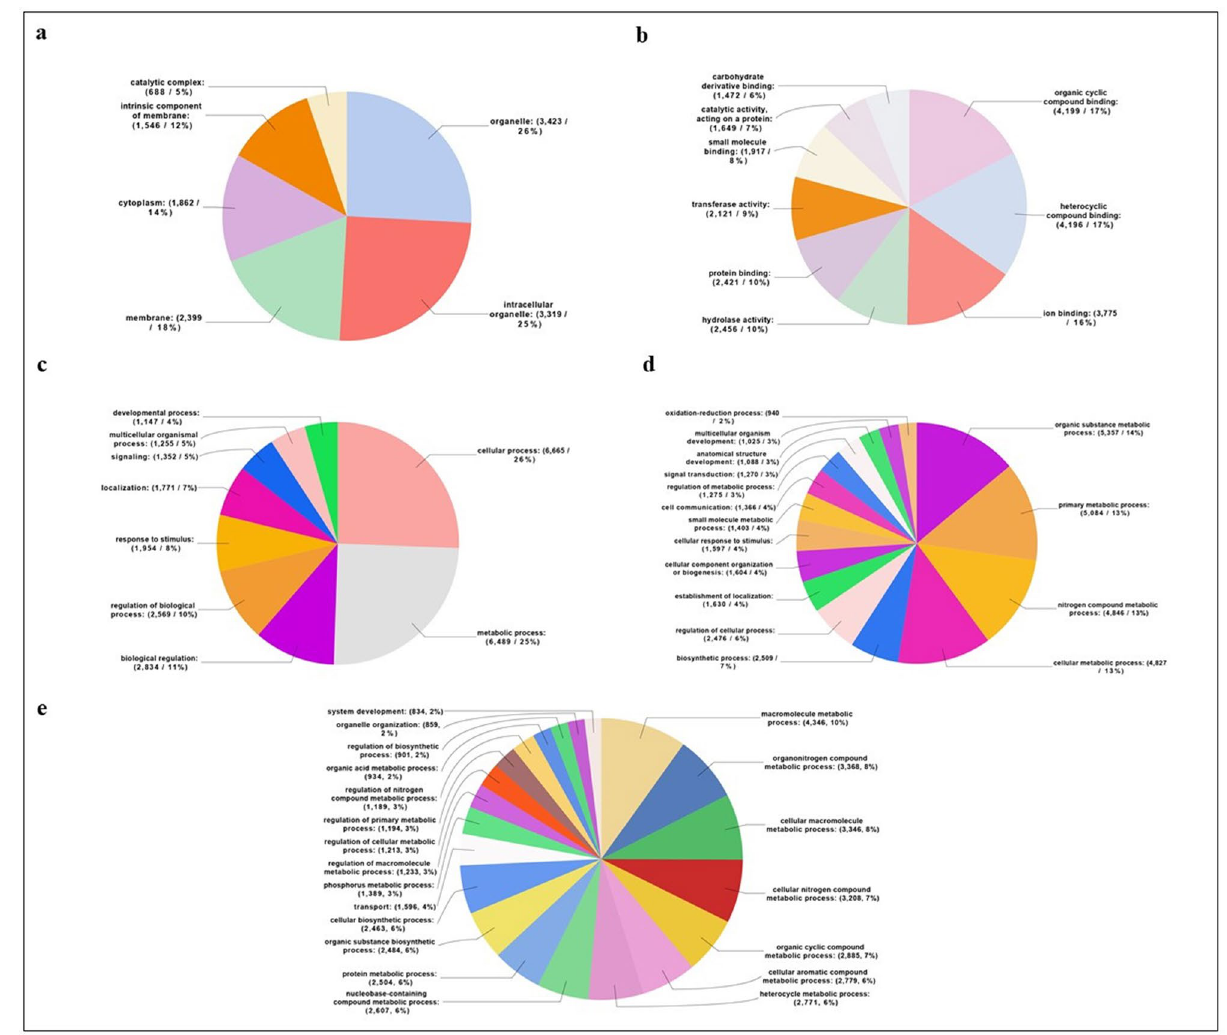
Figure 3. Gene Ontology sequence annotation. Functional classification of all nr-matched transcripts from the T. sinensis venom gland. ( a ) Cellular component; ( b ) molecular function; ( c – e ) biological process. Data are presented as level 2 GO category for Biological Process ( c ), level 3 GO category for cellular component ( a ), molecular function ( b ) and biological process ( d ) and level 4 GO category for biological process ( e ). Classified gene objects are displayed as total contig number and percentages of the total number of gene objects with GO assignments. Percentages below 2% are not